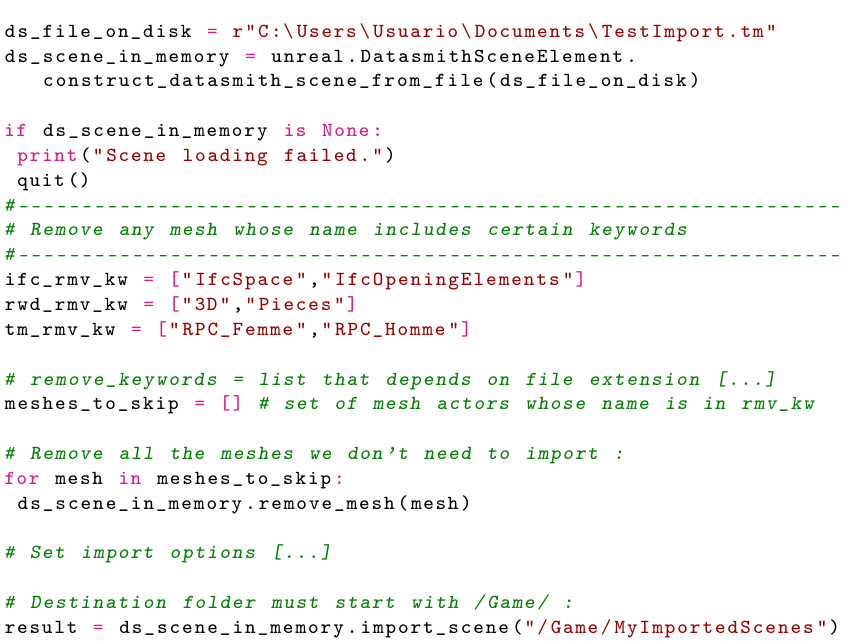
Figure A3. Unreal documentation: Datasmith-related Unreal